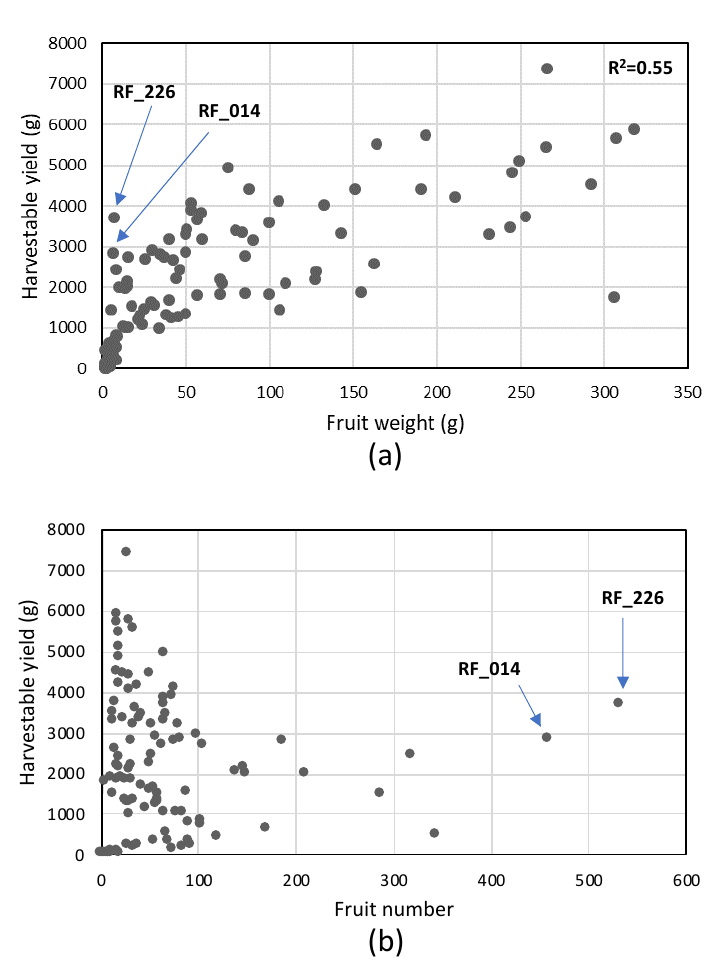
Figure 6. Scatter plot of fruit weight ( a ) and fruit number ( b ) versus harvestable yield.